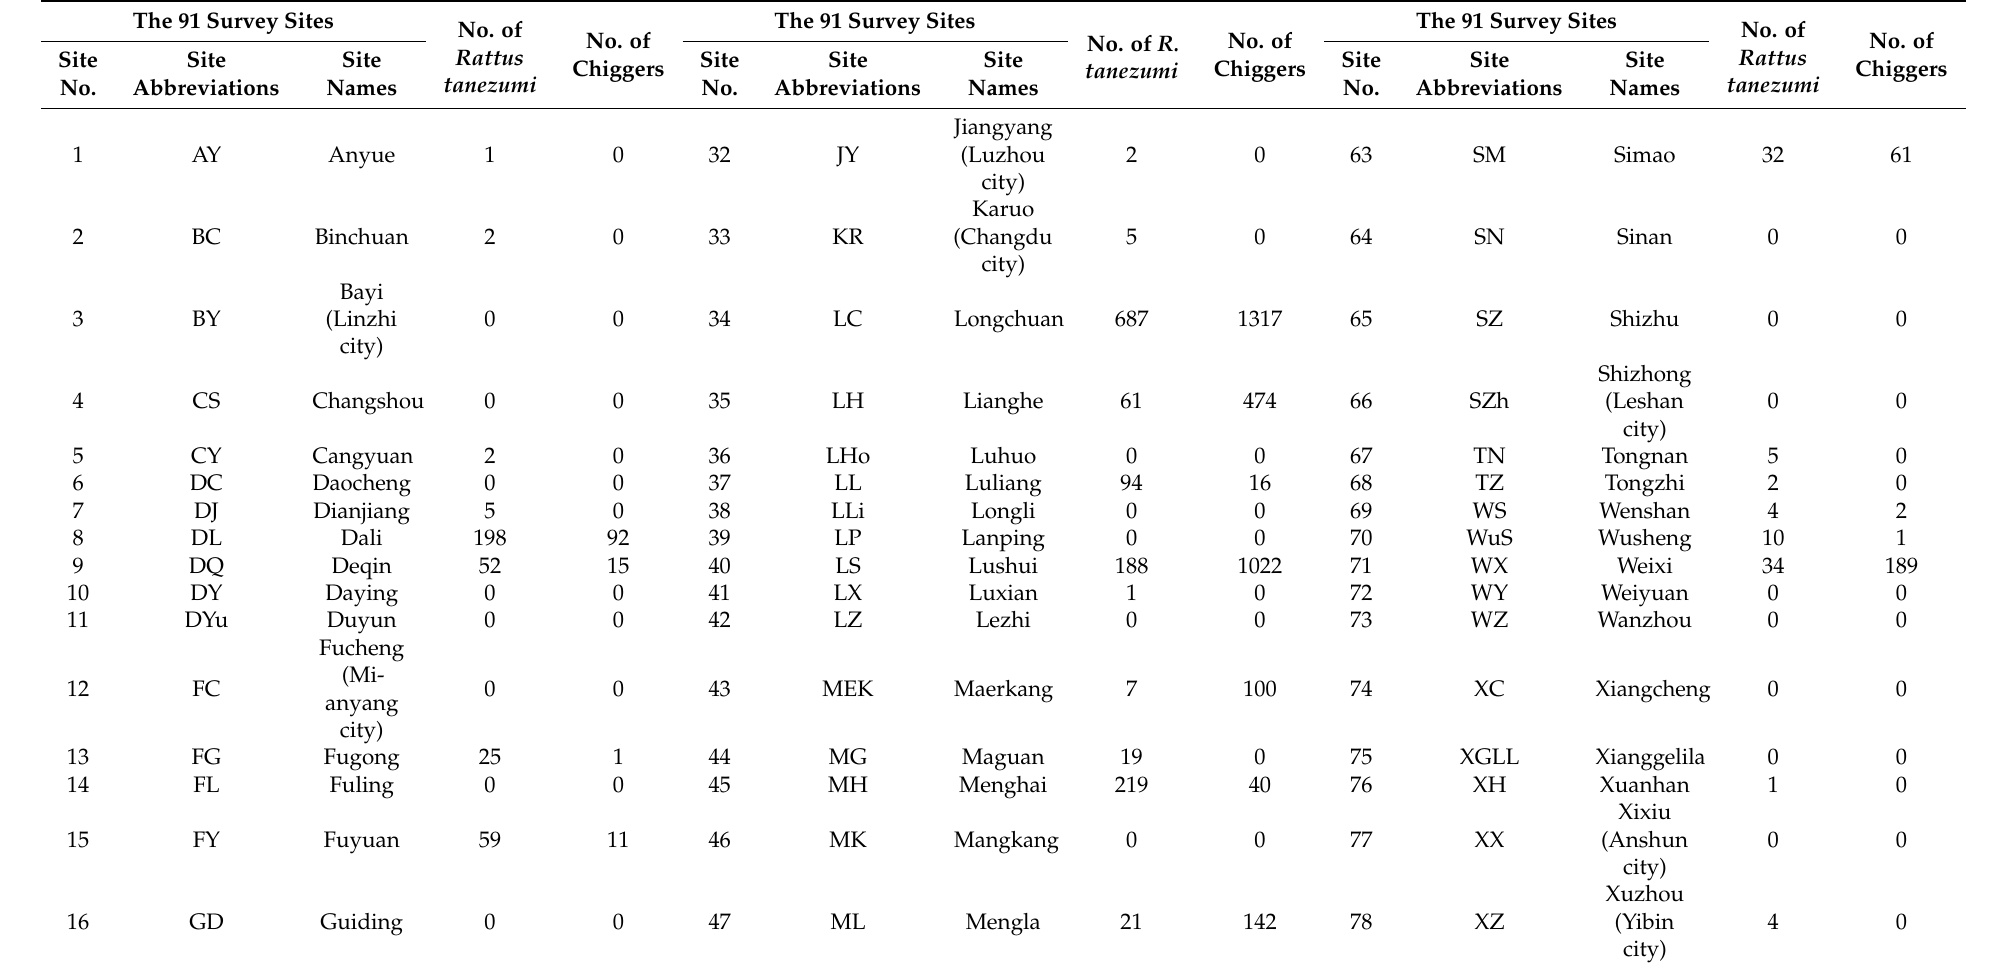
Table A1. A total of 91 survey sites and their abbreviations in 5 provincial regions of Southwest China